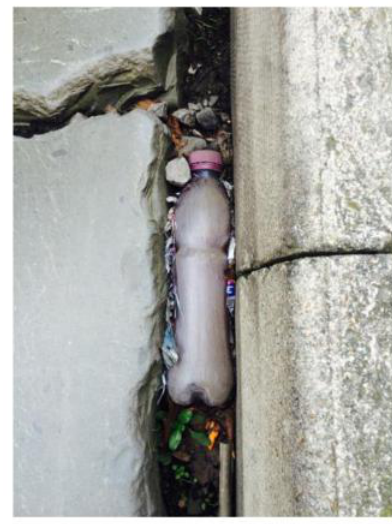
Figure 8. Plastic bottle buried in